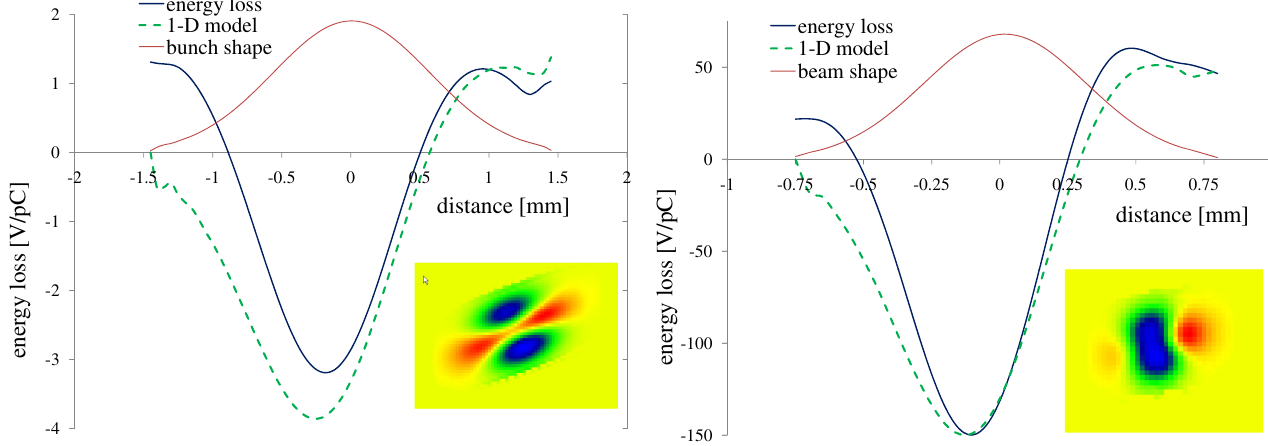
FIG. 10. Integrated energy loss along the transverse direction as a function of the longitudinal coordinate for two values of bending radius. The left plot corresponds to the upper plot at the right in Fig. 8. The right plot shows the result for a bending radius 40 times larger and a bunch length that is 2 times smaller. The green dashed line is from the analytical 1D model.